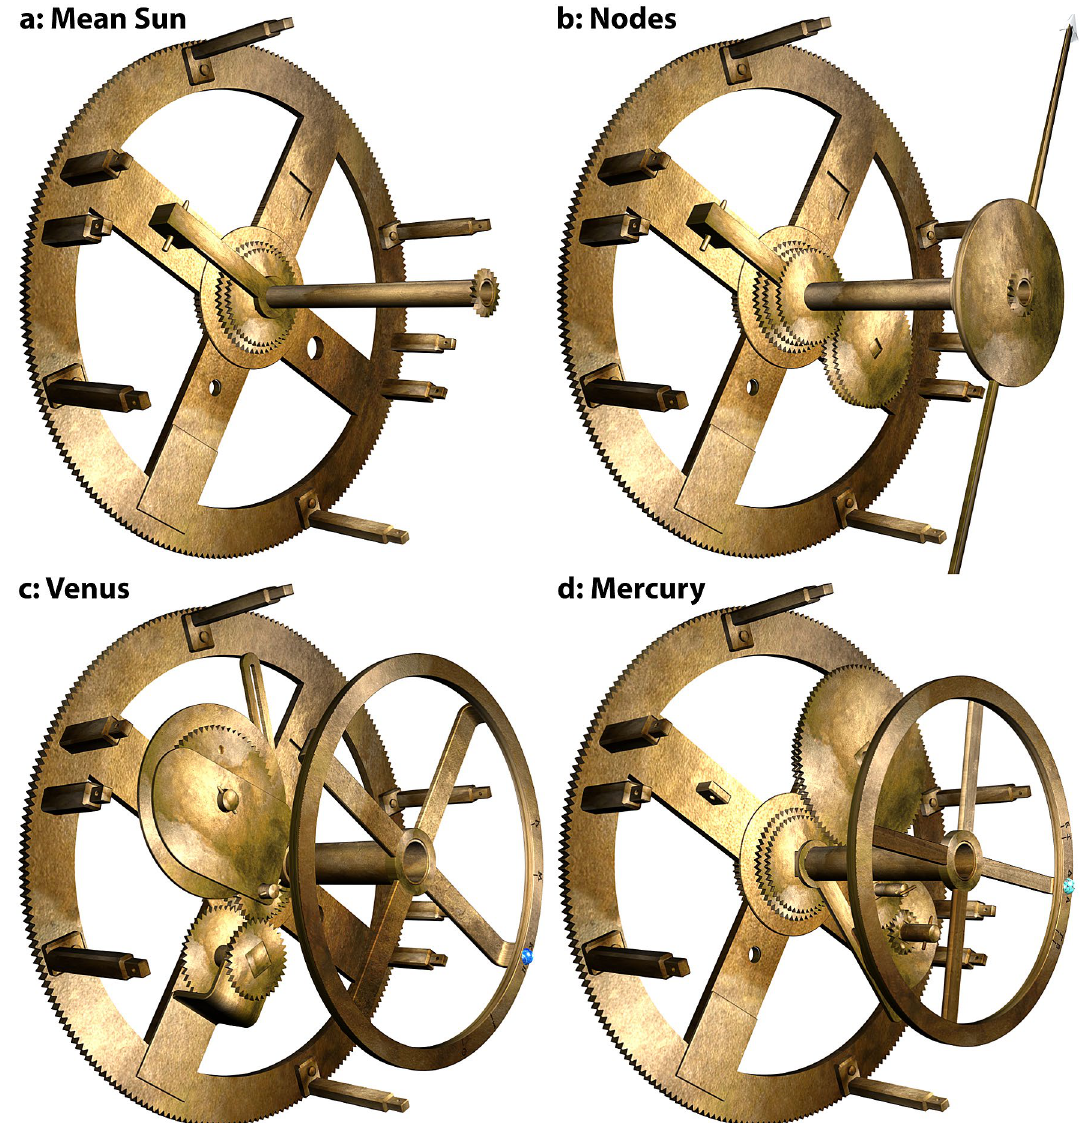
Figure 5. Mechanisms between b1 and the Strap. ( a ) Mean sun : Mean Sun bar attached to pierced block shown in Fig. 4e; tube and gear for input into Moon phase mechanism. ( b ) Nodes : Gears of Nodes mechanism, matching bearing in Fig. 4f—gear train 49 ~ 62 + 64 ~ 48 —with output tube and double-ended Dragon Hand . ( c ) Venus : Base gears of Venus mechanism match features in Fig. 4g. Gear train 51 ~ 44 + 34 ~ 26 ~ 63 —with components from Fragment D as reconstructed in Fig. 4p, plus output tube and Venus ring with lapis lazuli marker. The epicyclic gears 26 ~ 63 for Venus turn in the D-plate that is attached to the Strap (not shown). The end of the follower can be seen behind the disk. ( d ) Mercury : Base gears of Mercury mechanism match features in Fig. 4h. Gear train 51 ~ 72 + 89 ~ 40 ~ 20 —plus output tube and Mercury ring with turquoise marker. The epicyclic gears 40 ~ 20 for Mercury turn directly in the Strap (not shown). The follower can be seen behind the left-hand side of the Mercury a ring display for the Cosmos, with a single true Sun output for the solar ring. The small approximation inher- ent in using a mean Sun rather than a true Sun input to the Moon phase is negligible at the scale of the 6 mm diameter Moon phase sphere. There are great advantages in a ring system of outputs as opposed to a pointer system. It coincides far better with the description of the output display in the BCI. It eliminates the severe parallax inherent in a pointer system with nine outputs. It greatly enhances the astronomical outputs, by enabling the synodic phases of the planets to be described by index-linked inscriptions, as we discuss later (Fig. 8). It leads to a robust and elegant display. The close match between our proposed mechanisms and the data is shown in Fig. 4. The four spokes of b1 suggest four different functions (Supplementary Fig. S12). The mean Sun and inferior planets take up three of these. What is the function of the prominent bearing on Spoke B (Fig. 4f)? Fig. 5b shows a solution: the bearing enables a four-gear epicyclic system that calculates the lunar nodes. Our proposed tooth counts for the gears